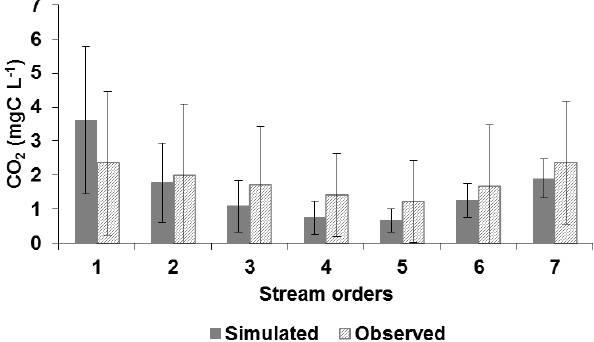
Figure 4. Carbon dioxide concentrations in the Seine waters (CO 2 , mgCL − 1 ) simulated by the pyNuts-Riverstrahler model (dark gray) and observed (light gray ) as a function of the stream order averaged over the 2010–2013 period (whiskers indicating standard deviations).